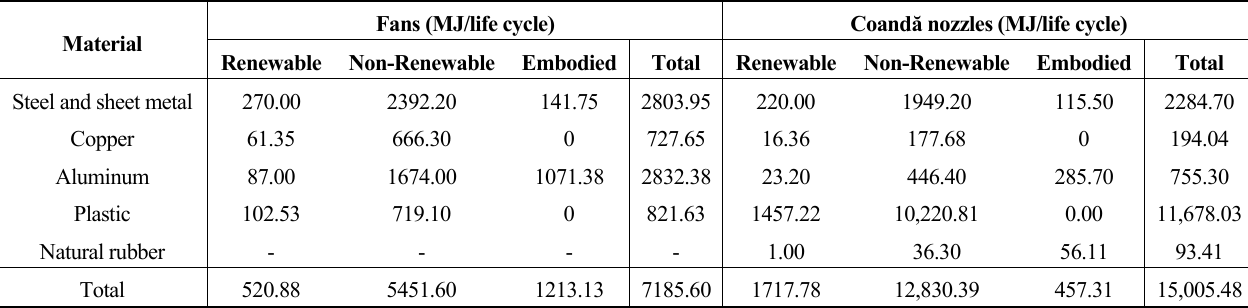
Table 4. Primary energy (MJ) used in the production of both studied ventilation systems over the 25 year life cycle.